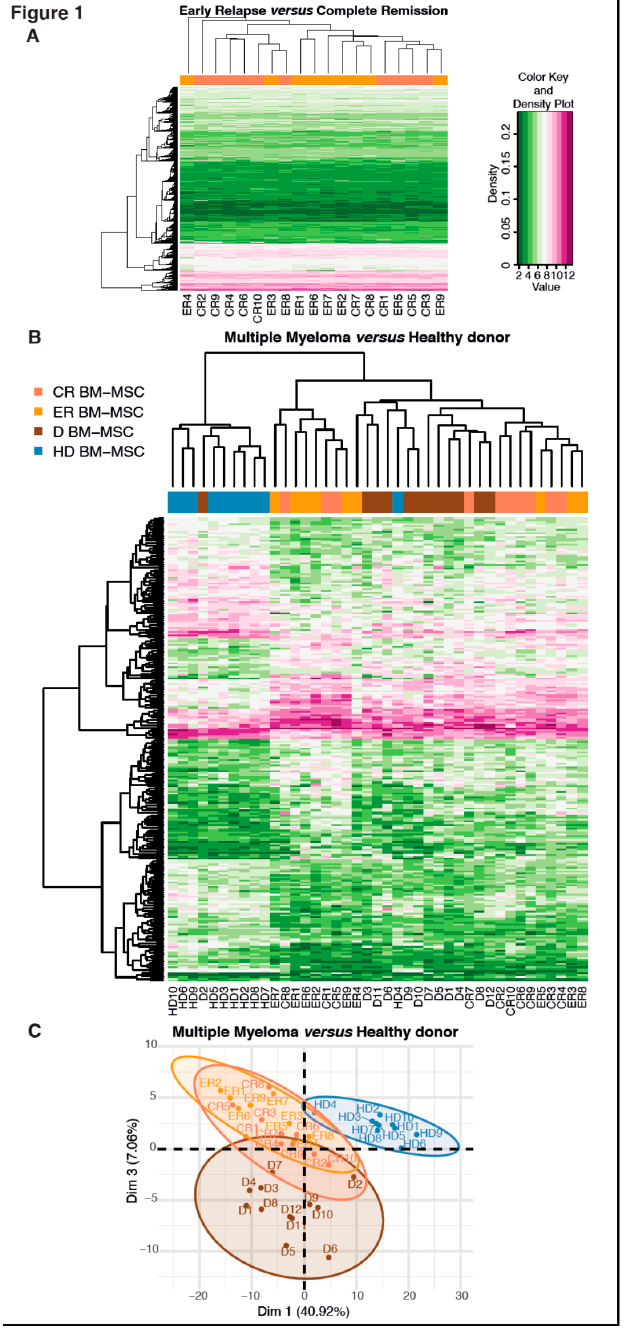
Figure 1. Transcriptional profile of ER and CR BM-MSC and clustering differences between HD and MM BM-MSC. ( A ) Unsupervised gene expression analysis of ER BM-MSC ( n = 9) and CR BM-MSC ( n = 10), representing a heatmap, with underexpression of green and overexpression of pink. No differences were observed between ER BM-MSC and CR BM-MSC, after the MM treatment. ( B ) Heatmap of 231 (108 upregulated in pink and 123 downregulated in green) differentially expressed genes in the MM BM-MSC (ER, CR and D BM-MSC) versus the HD BM-MSC. Expression data were filtered by the adjusted p -value < 0.05 and 2 < FC < 0.5. ( C ) Two-dimensional principal component analysis (PCA) of all MSC subtypes with representation of dimensions 1 and 3. There are three clusters based on the differences in their transcriptomic profiles. Expression data were filtered by the adjusted p -value < 0.05 and 2 < FC < 0.5.